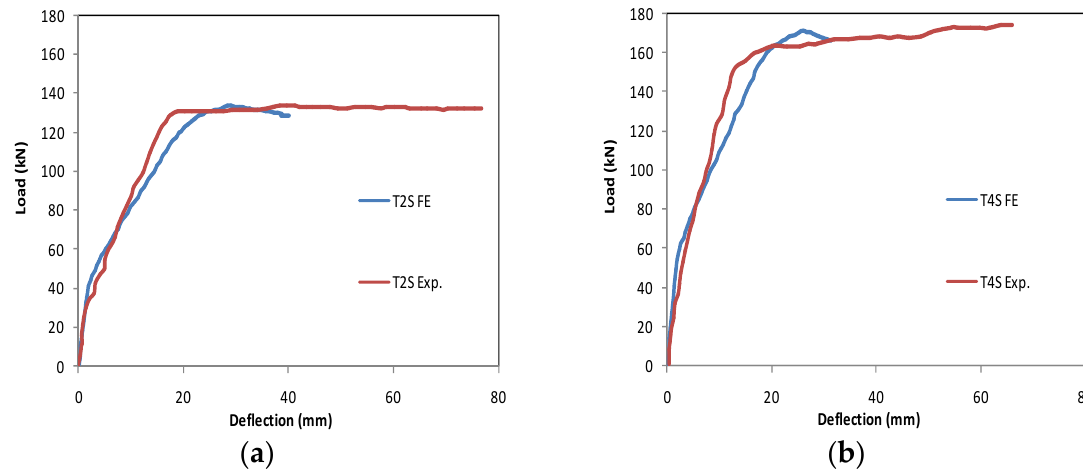
Figure 12. Load–deflection curves of experimental tests [19] and FE models: ( a ) specimen T2S; ( b )